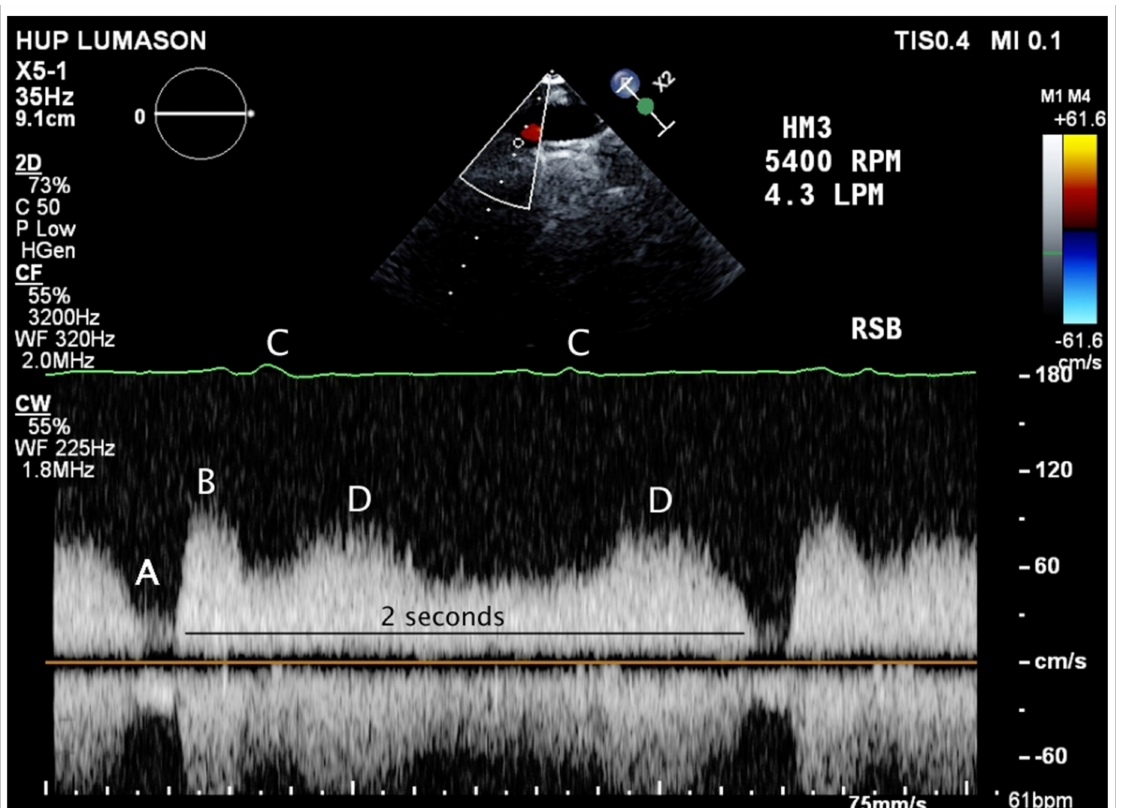
Figure 3. Echocardiography of LVAD patient. Continuous wave Doppler interrogation of the aorta from the right sternal border demonstrating the unique physiology of a patient with a normally functioning HeartMate 3 left ventricular assist device (LVAD). Every 2 s, the artificial pulse feature causes an abrupt decline ( A ), then increase ( B ) in flow delivered to the aorta. Following electrical systole on the ECG tracing ( C ), mechanical ventricular systole decreases the aorta-ventricular pressure gradient, which increases flow through the pump ( D ). An analogous tracing would be found on an invasive arterial line in the critical care unit. Despite the flow variation during the cardiac and LVAD “artificial pulse” 30 Hz cycle, this patient does not have a palpable pulse and the aortic valve does not